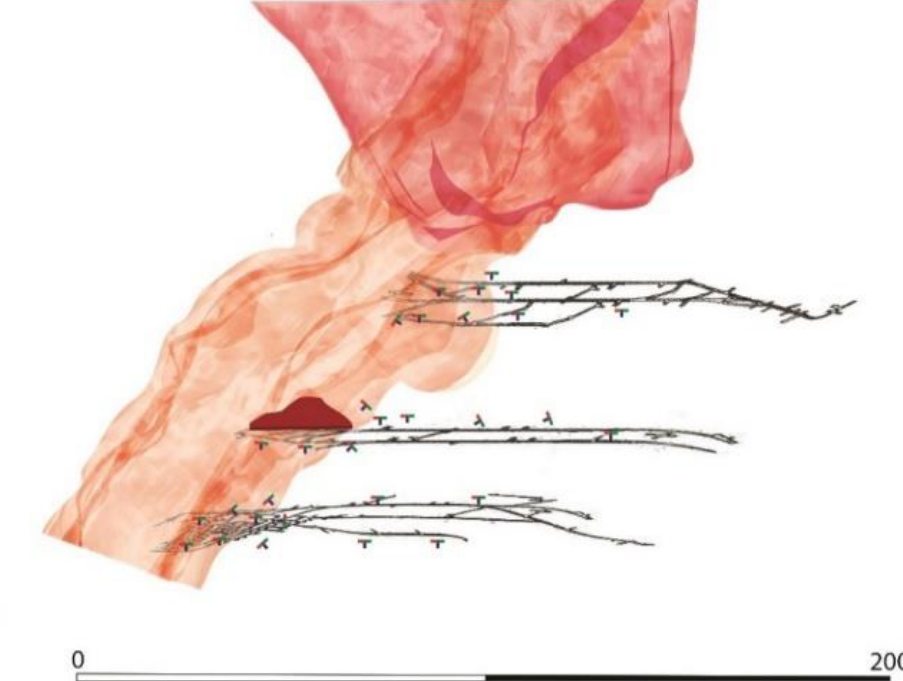
Figure 1. Illustration of underground mine seismometer network design in an intrusion geological setting. The intrusion body is depicted in orange; red coloring indicates an open pit; the cave model is depicted in brown; seismometer stations are represented by the letter T; and Haulage Shaft (mining facility area) is indicated by double black lines.